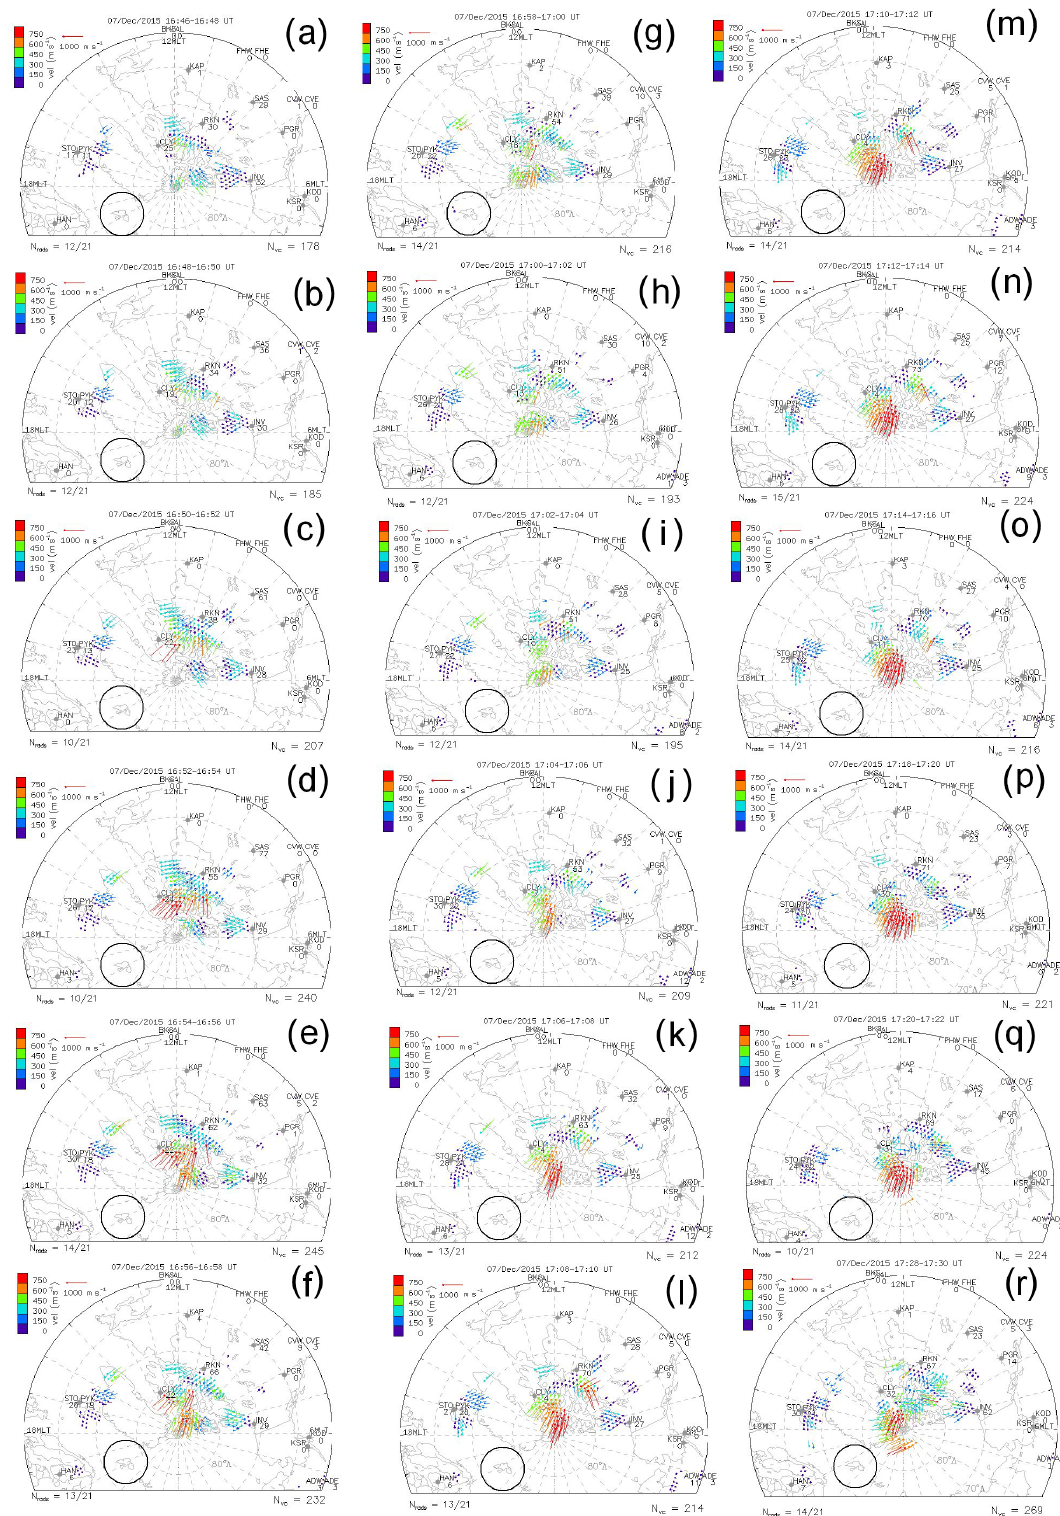
Figure 4. Series diagrams showing global convection patterns averaged over 2min. Gridded line-of-sight velocity vectors are plotted at points where velocity data were provided by measurements. Large circles border the working field of view of the all-sky camera in Barentsburg